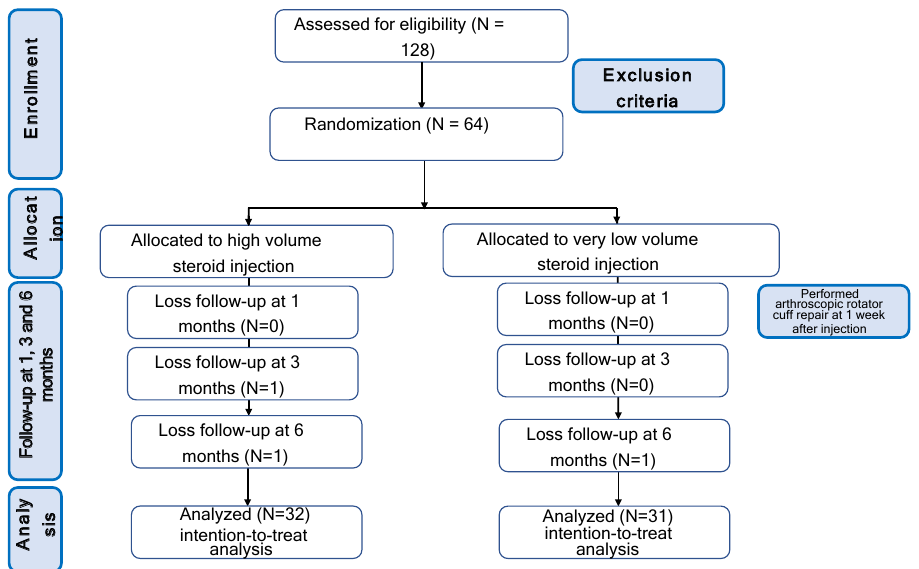
Figure 2. Consolidated Standards of Reporting Trial (CONSORT) diagram for the recruitment and flow of participants through the